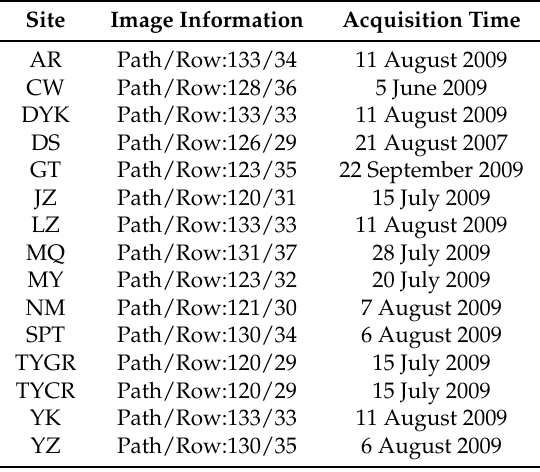
Table 2. Basic information of the acquired images (Landsat-5